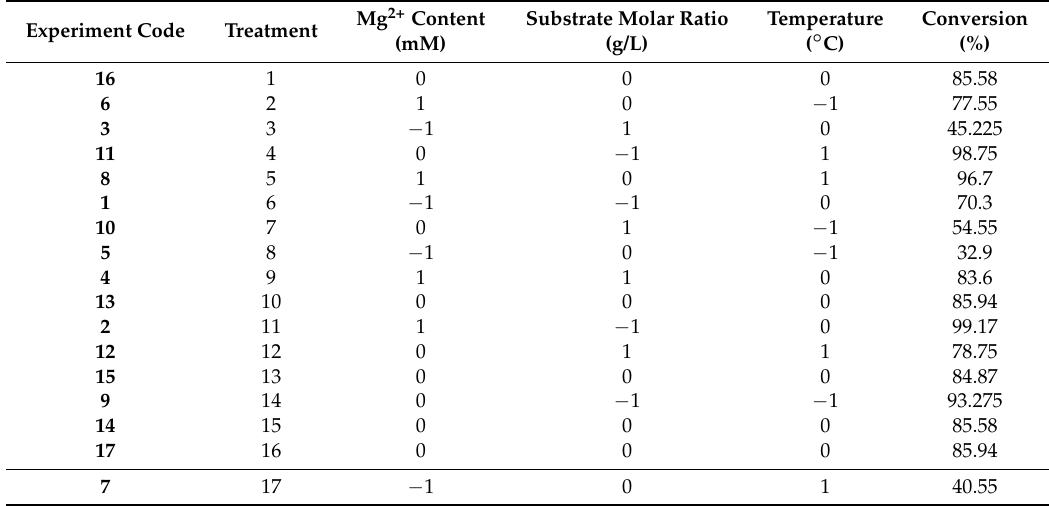
Table 3. Box–Behnken design (BBD) experimental design table and